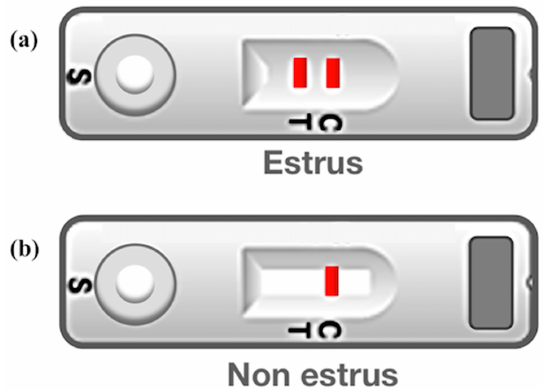
Figure 1. Results of fabricated bovine heat detection kit. ( a ) A positive test result for estrus is indicated by two red lines. ( b ) A negative test result for estrus (i.e., non-estrus) is indicated by one red line. C, control line; T, Test line; S, sample (the location to drop the sample). 2.6. Statistical Analysis All data were expressed as the means with standard error (SE) and were visualized in R 3.1.2 [17].